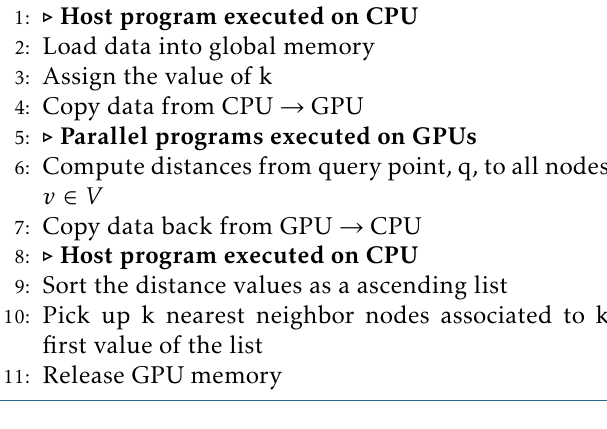
Algorithm 4 Find shortest path from each sensor node Algorithm 5 RNN-CUDA